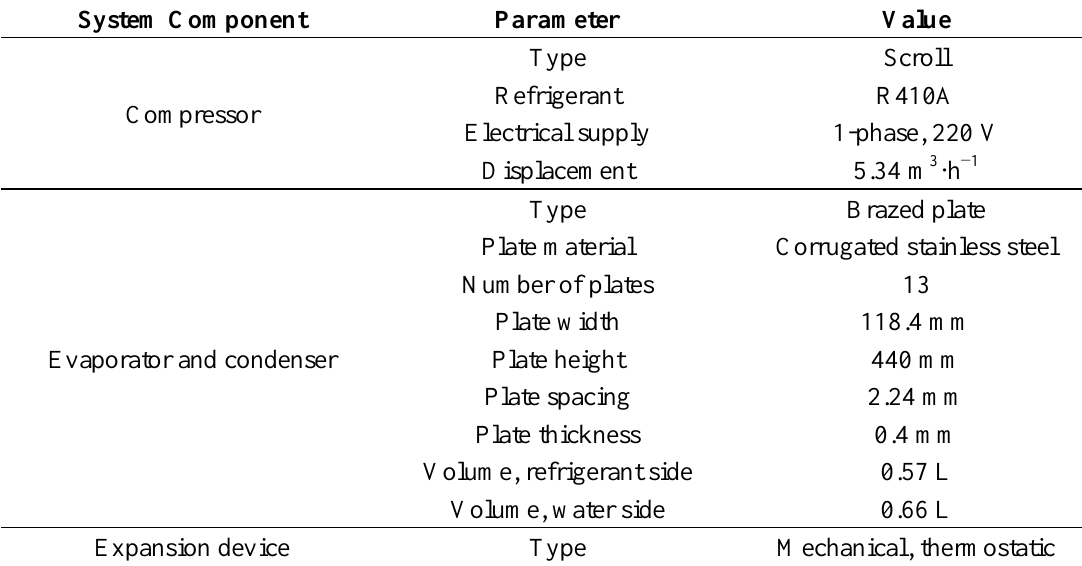
Table C1. Details of the test heat